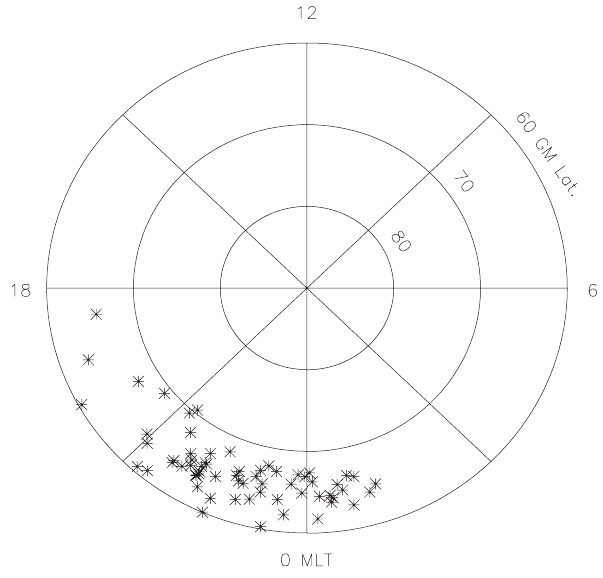
Fig. 3. Geomagnetic latitudes and magnetic local times of some substorm onsets used in this